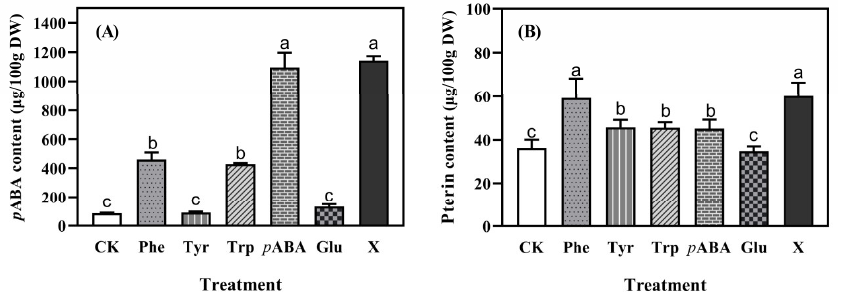
Figure 3. Contents of p -aminobenzoic acid ( p ABA); ( A ) and pterin ( B ) in wheat seedlings. CK was wheat seedlings cultured with distilled water; Phe, Tyr, Trp, p ABA, and Glu were seedlings cultured with 1.00 mM phenylalanine, 0.25 mM tyrosine, 0.50 mM tryptophan, 0.25 mM p -aminobenzoic acid, and 1.00 mM glutamate, respectively; X was seedlings cultured with the optimized culture solution (1.50 mM phenylalanine, 0.50 mM tyrosine, 0.50 mM tryptophan, 0.75 mM p -aminobenzoic acid, and 0.50 mM glutamate). a–c represent significant differences among treatment factors ( p < 0.05).